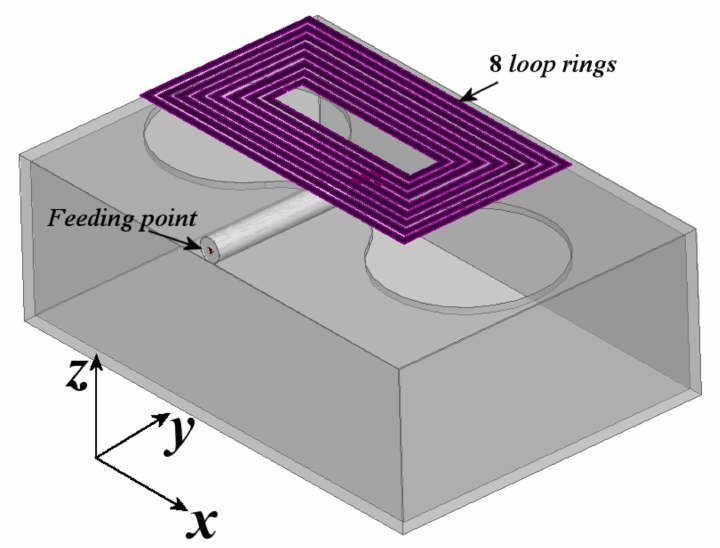
Figure 12. Proposed configuration of 8 rectangular loops combined with dumbbell-shaped slot radiator and box reflector.